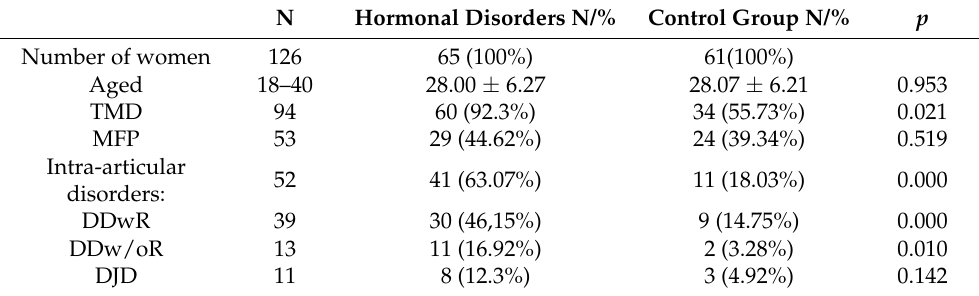
Table 2. Comparison of the frequency of TMD in females with hormonal disorders and the